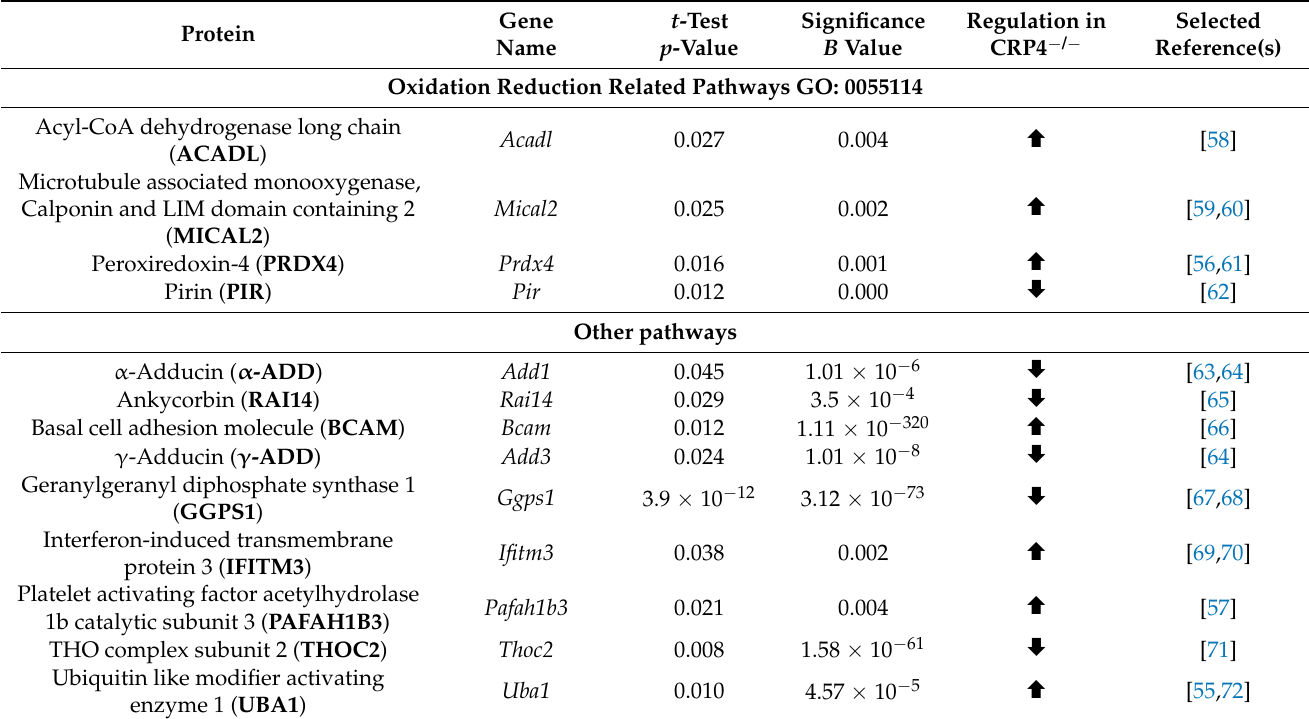
Table 1. Proteomic analysis of P10-15 VSMCs.